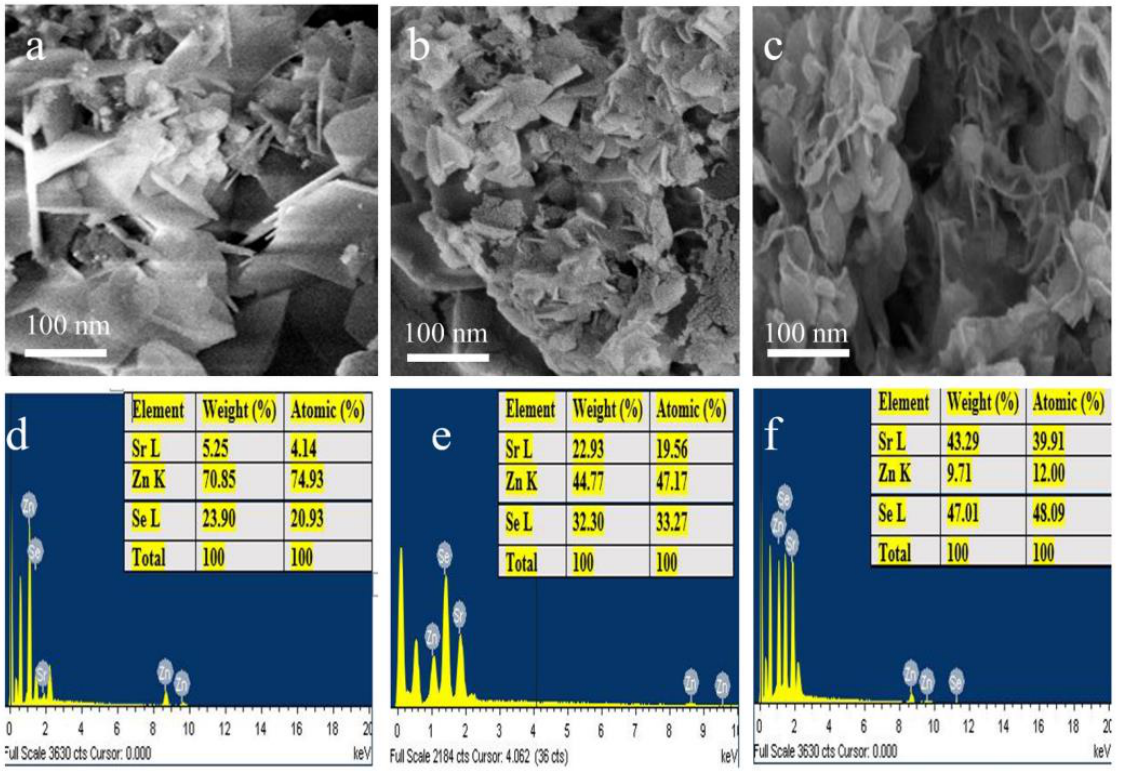
Figure 5. ( a – c ) FE-SEM images and ( d – f ) EDS spectra of Sr (0.01, 0.05, and 0.1)-doped ZnSe nanoparticles.